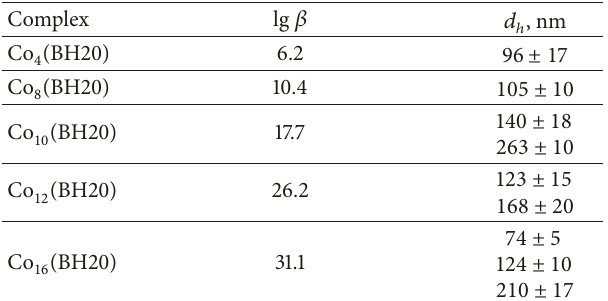
Table 1: Stability constants (lg 𝛽 ), hydrodynamic diameter ( 𝑑 ℎ ), and concentration of c omplexes Co 𝑛 (BH20) in aqueous